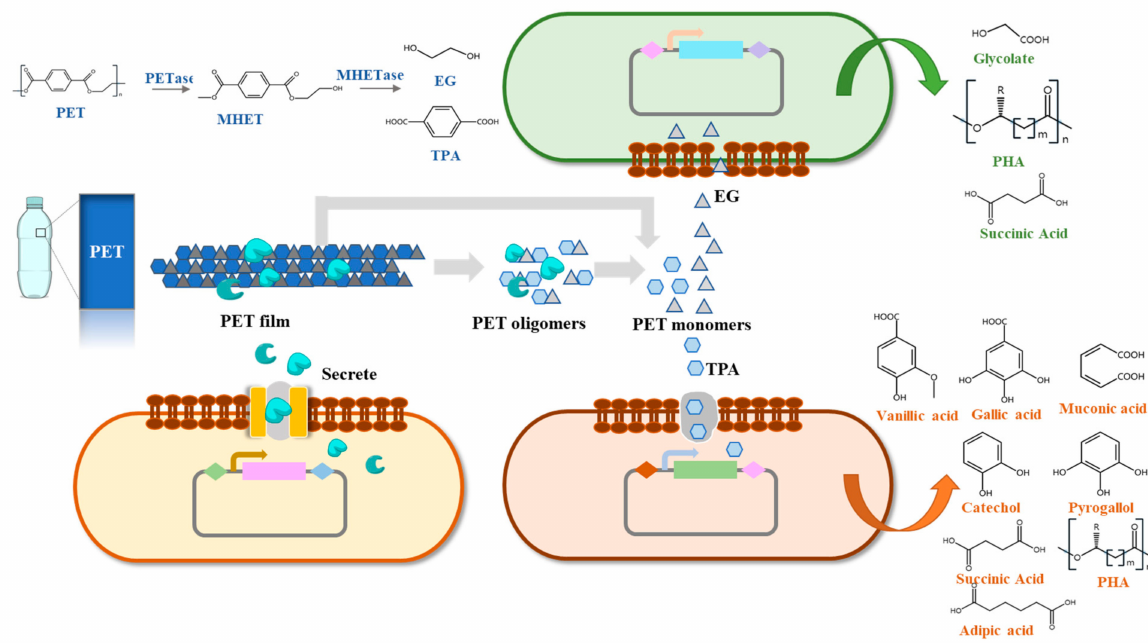
Figure 2. Artificial microbial consortia for PET biodegradation and